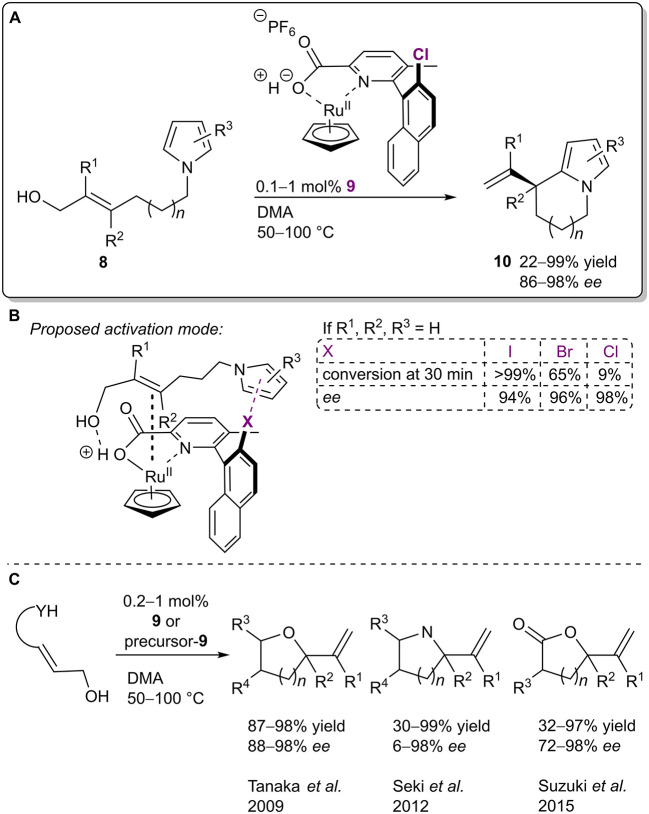
(A) Ruthenium-catalyzed dehydrative cyclization of allylic alcohols 8; (B) proposed activation mode and influence of the halogen atom on the reaction; (C) other dehydrative cyclizations performed in the presence of 9 or its precursors.